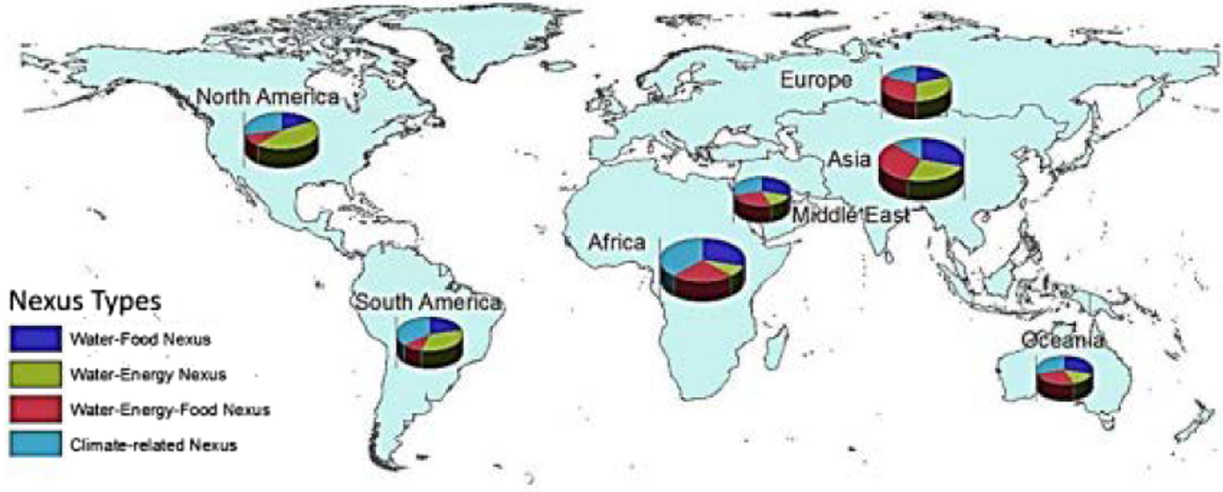
Fig. 9 A graphical representation of nexus types in different regions (Endo et al. 2017) Table 2 Nexuses types and most and least dominant regions with respect to nexus type (Endo et al.